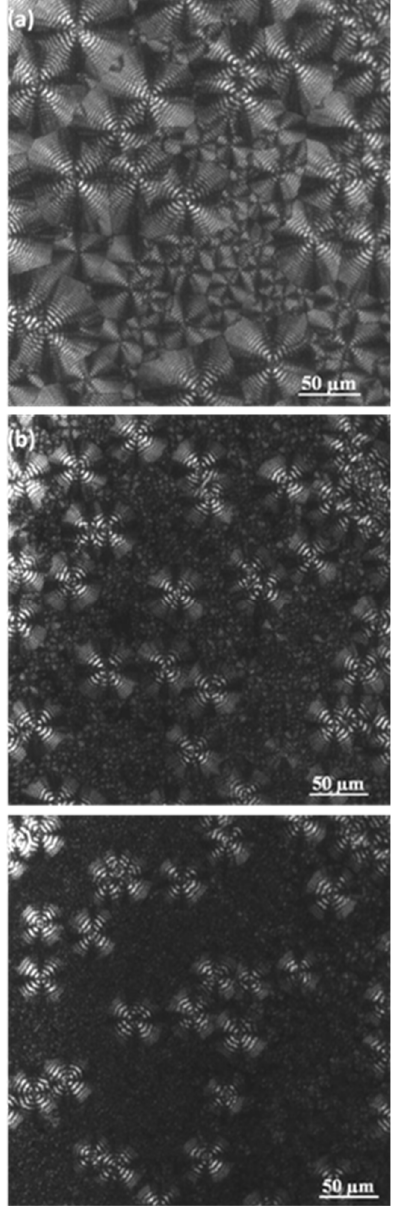
Figure 12. Optical micrographs taken at the end of the non-isothermal crystallizations of P4HB performed at cooling rates of 0.5 °C/min ( a ), 3 °C/min ( b ) and 5 °C/min ( c ). Morphology of constitutive lamellae depends not only on the crystallization rate, as indicated for the twisting period (i.e., interring spacing), but also on the lamellar thickness. Small-angle X-ray scattering patterns (SAXS) taken in real-time during the cooling process allowed to follow the